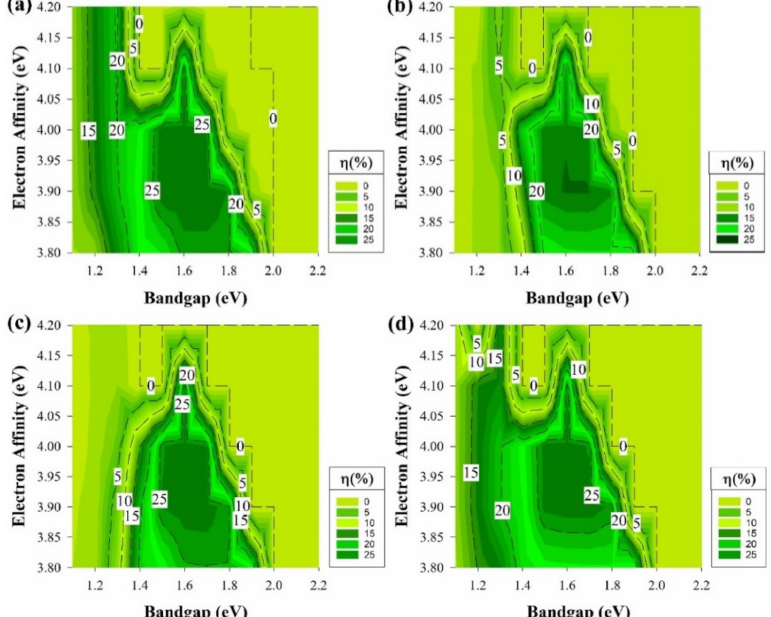
Figure 11. The efficiency of four proposed structures as a function of Eg and χ for all passivating and doped layers, including defects at the 0.2 eV level below Ec. ( a ) Contour graphs of the n-i-p structure with p-type wafer base. ( b ) Contour graphs of the n-i-p structure with n-type wafer base. ( c ) Contour graphs of the p-i-n structure with the p-type wafer. ( d ) Contour graphs of the p-i-n structure with n-type wafer base. ( a – d ) All graphs show the efficiency performance while varying the Eg and χ .